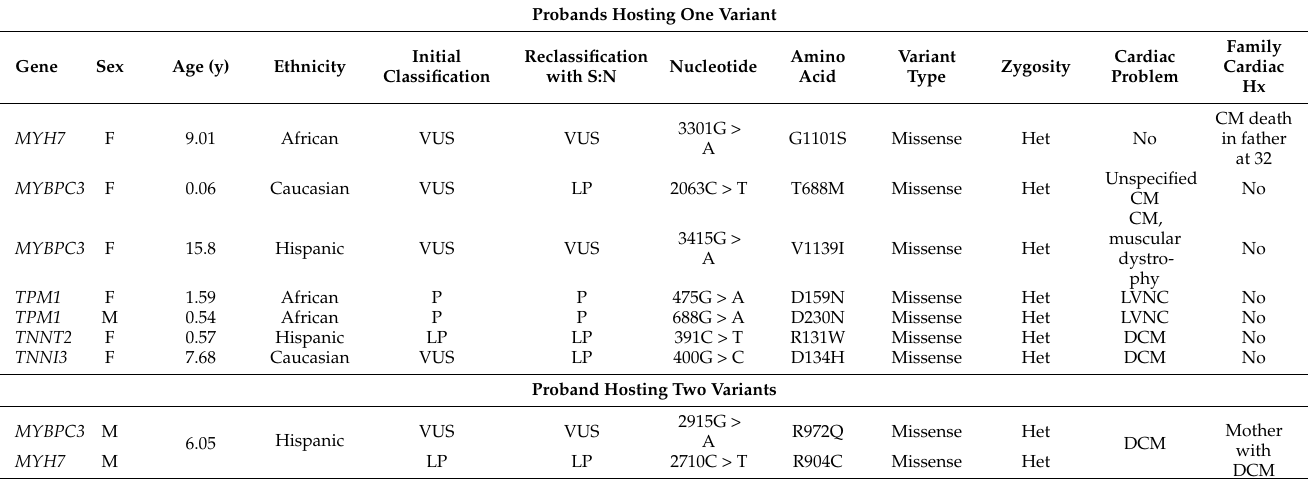
Table 2. TCH cohort